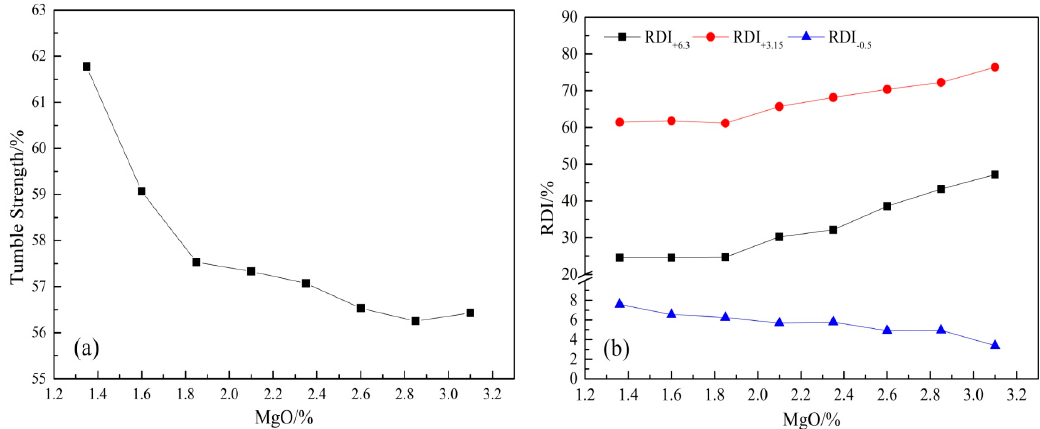
Figure 2. ( a ) Effects of MgO on cold strength of sinter; ( b ) effects of MgO on the RDI of sinter in Figure 2. ( a ) E ff ects of MgO on cold strength of sinter; ( b ) e ff ects of MgO on the RDI of sinter in reducing condition simulated COREX shaft furnace. reducing condition simulated COREX shaft furnace.